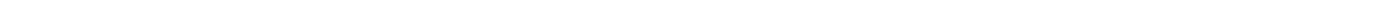
Fig. 2 Feedback-stabilized RNNs exhibit a robustness – fl exibility trade-off. a (Left) The network architecture. Trained connections are in red. (Middle, right) Firing rates of example neurons and the network outputs. b Training performance (test error, Methods) and timing failure rate (the frequency with which the network fails to produce all 10 intervals within 6% of their target durations over 400 trials) versus feedback strength. c The distance between two instantaneous population fi ring rate vectors, each constructed at the beginning of an interval (Methods), averaged over all interval pairs for intervals 3 – 10, 20 fsRNNs and 100 runs over each fsRNN. d Timing failure rate in response to a perturbation pulse ( P ) versus feedback strength. Error bars show standard error across 20 fsRNNs. e Example interference matrices for fsRNNS. f Average interference calculated from the interference matrix. The plot shows averages over all pairings of intervals 2 – 10 for 20 fsRNNs at each feedback strength. g Examples of a reinforcement learning ‘ experiment ’ that targeted interval 3 for lengthening. h Learning rate (the absolute value of the change in the target interval duration after 1000 trials) averaged over 20 learning ‘ experiments ’ in 20 trained networks. i Interval duration changes (Methods) after 1000 trials for the ‘ experiments ’ in g , averaged across 20 different simulations, regressed to the elements of the 3rd row (i.e., those associated with the target interval) of the networks ’ interference matrices. Error bars show standard error across 20 simulations; r denotes Pearson correlation coef fi cient. j The analysis of i applied to 100 fsRNNs (20 trained networks for each of g FB = 0.5, 1, 1.5, 2, 3), two times each, one for stretching and one for shrinking the 3rd interval. The median correlation coef fi cient over the 200 regressions performed is plotted. Error bars denote 25th and 75th percentiles, respectively. k Change in non-targeted intervals in the fi rst 1000 trials of reinforcement learning simulations, relative to the change in the target interval (interference). Average over all non-target intervals and 20 simulations across 20 fsRNNs as a function of feedback strength. The blue portion of the bars show the average interference calculated from the interference